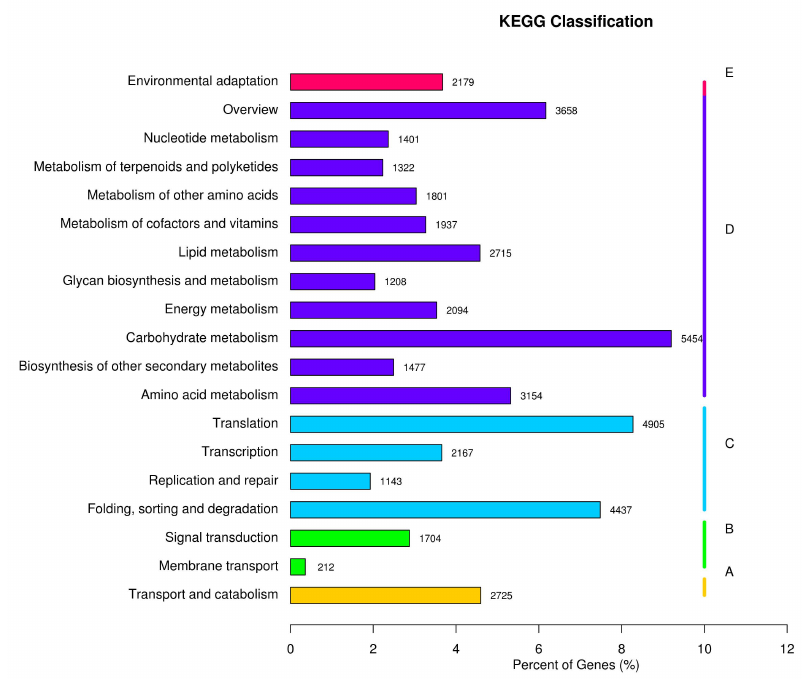
Figure 4. KEGG pathway annotation. ( A ) cellular processes; ( B ) environmental information process- ing; ( C ) genetic information processing; ( D ) metabolism; and ( E ) organismal systems. All the unigenes were assigned to different categories, including biological process, cellular component and molecular function (Figure 5). After annotation by the GO